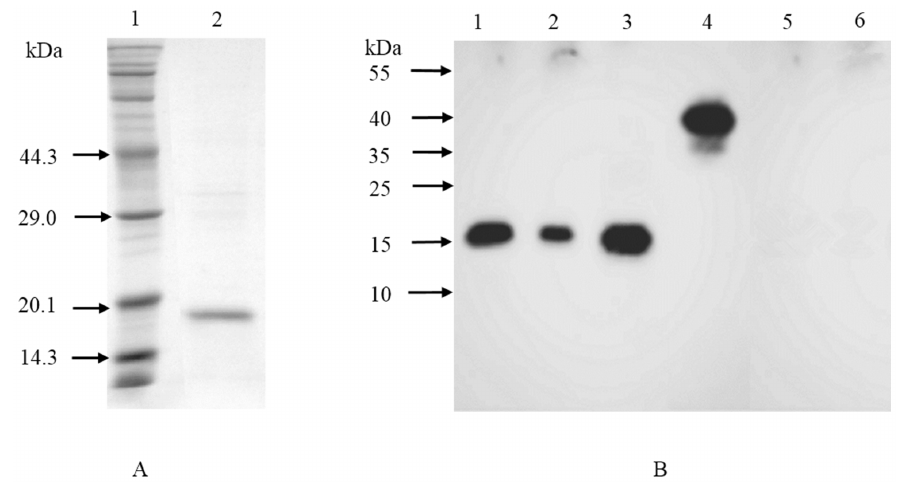
Figure 2. SDS-PAGE analysis of purified Der p2 from the recombinant E.coli (A). Lane 1: protein marker, Lane 2: purified Der p2. Western blot analysis of recombinant Der p2-producing L.lactis strains (B). Lane 1: purified Der p2 from recombinant E. coli , Lane 2: the culture from strain LL-E, Lane 3: the cell extract of strain LL-I, Lane 4: the cell wall extract of strain LL-W, Lane 5, 6: the culture or cell extract from wild-type L. lactis .